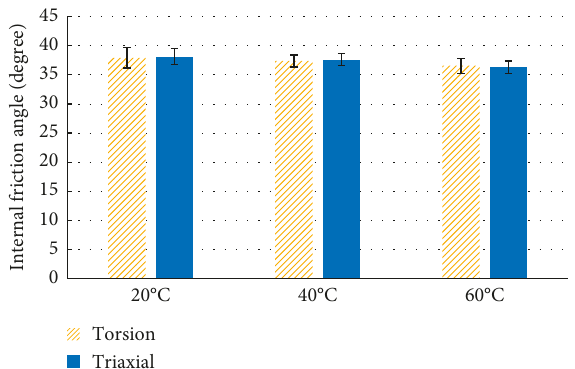
Figure 16: Results of internal friction angle φ at different temperatures.